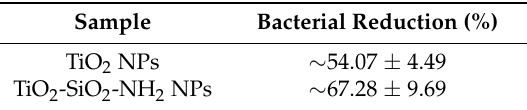
Table 2. Bacterial reduction of E. coli achieved by a-TiO 2 -based